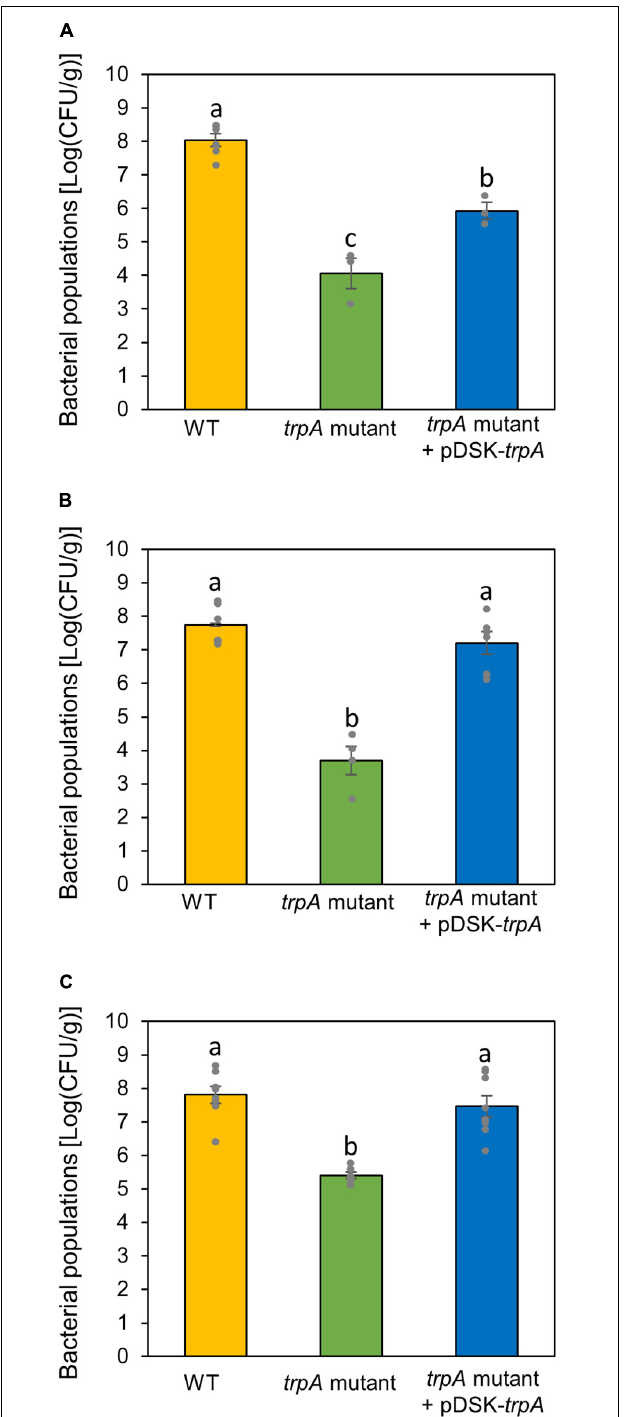
FIGURE 6 | Bacterial populations of Pseudomonas cannabina pv. alisalnesis KB211 WT and the trpA mutant in Japanese radish (A) , broccoli (B) , and Chinese cabbage (C) . All plants were spray inoculated with 5 × 10 7 CFU/ml of inoculum containing 0.025% Silwet L-77. Bacterial concentrations in the plant leaves were evaluated at 5 dpi. Vertical bars indicate the standard error for at least three biological replicates. Different letters indicate a significant difference among treatments based on a Tukey’s HSD test ( p <